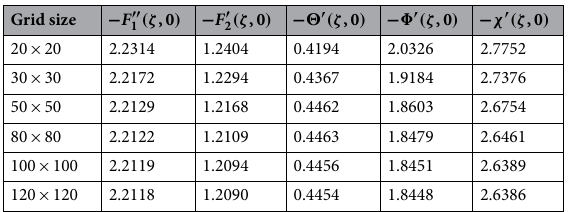
Table 3. Analysis of grid independence for distinct grid sizes at ζ